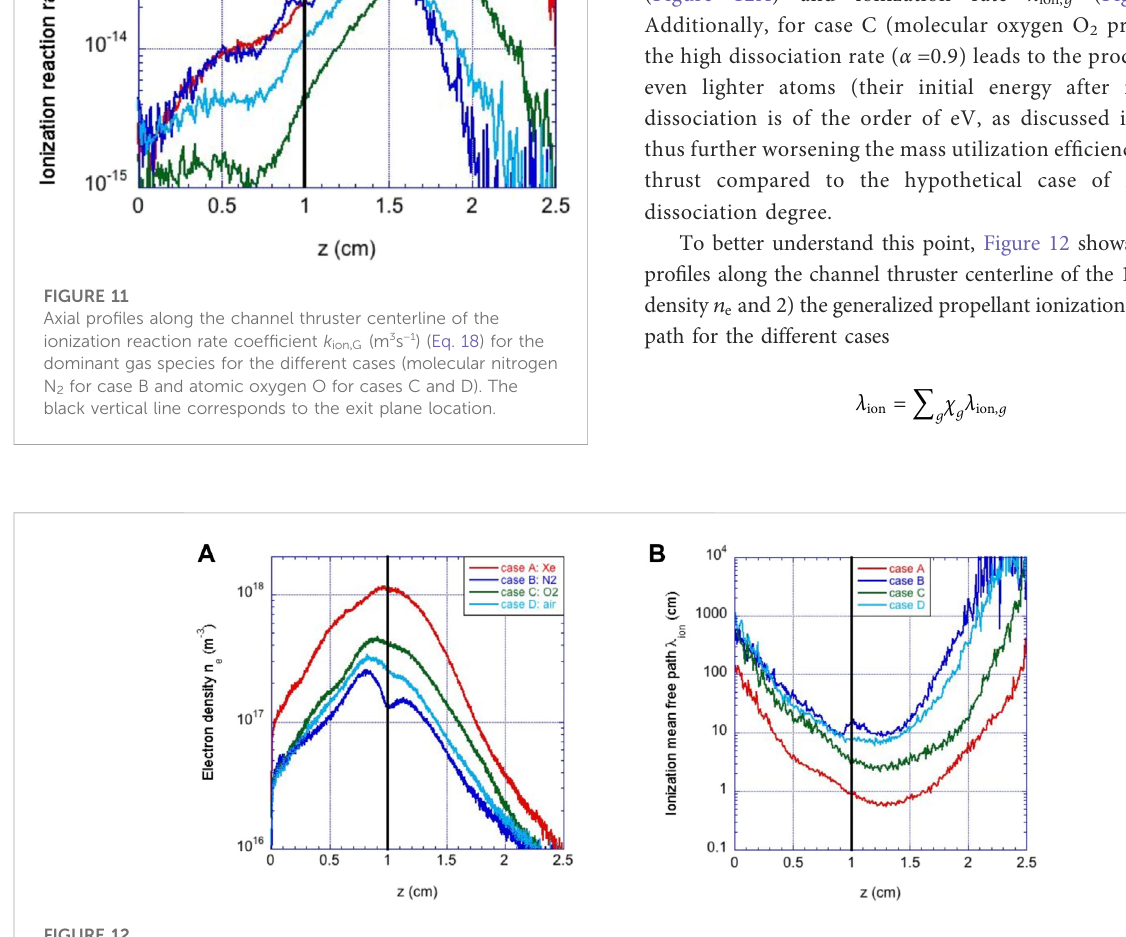
FIGURE 12 Axial pro fi les along the channel thruster centerline with (A) electron density n e (m − 3 ) and (B) propellant ionization mean free path λ ion (cm) (Eq. 23). The black vertical line corresponds to the exit plane location.